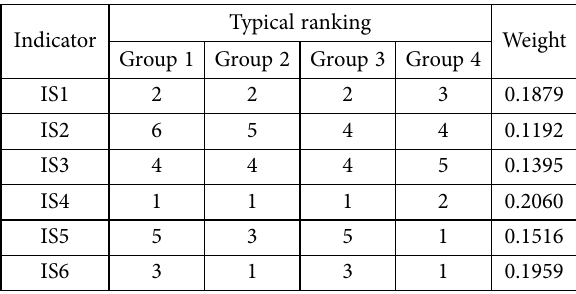
Table 2. Calculation of the weights of indicators